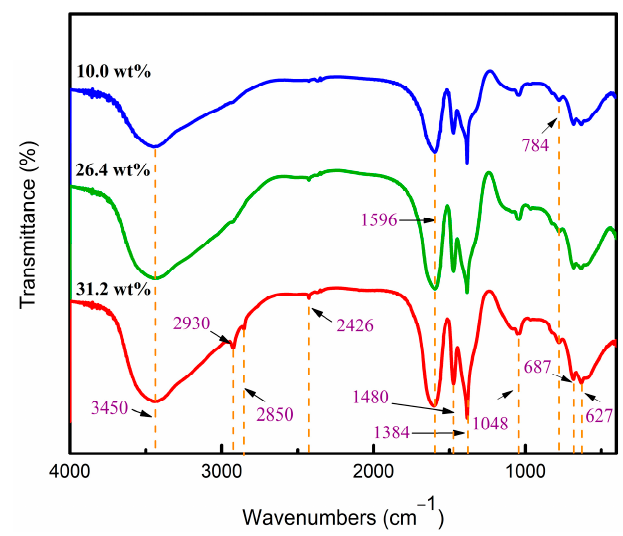
Figure 5. FT-IR spectra of aluminum sols and gels.